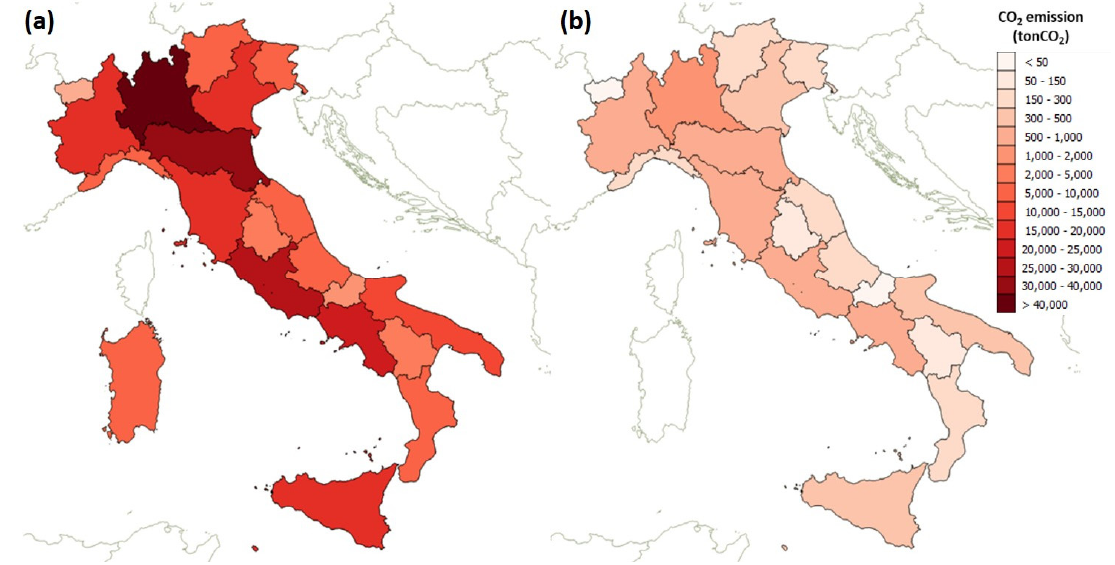
Figure 5. Qgis geographical visualization of CO 2 emissions (E) associated with: ( a ) surgical masks consumption; ( b ) fabric masks consumption. Data were calculated considering the period from March 2020 to December 2021. These data were evaluated only considering the materials used. Carbon footprint associated with transport of surgical masks from abroad cannot be evaluated for each region (however a global value of 59 kton of CO 2 per year due to the air transport was estimated [28]. Carbon Footprint associated with the transport of fabric masks is not considered in the analysis.